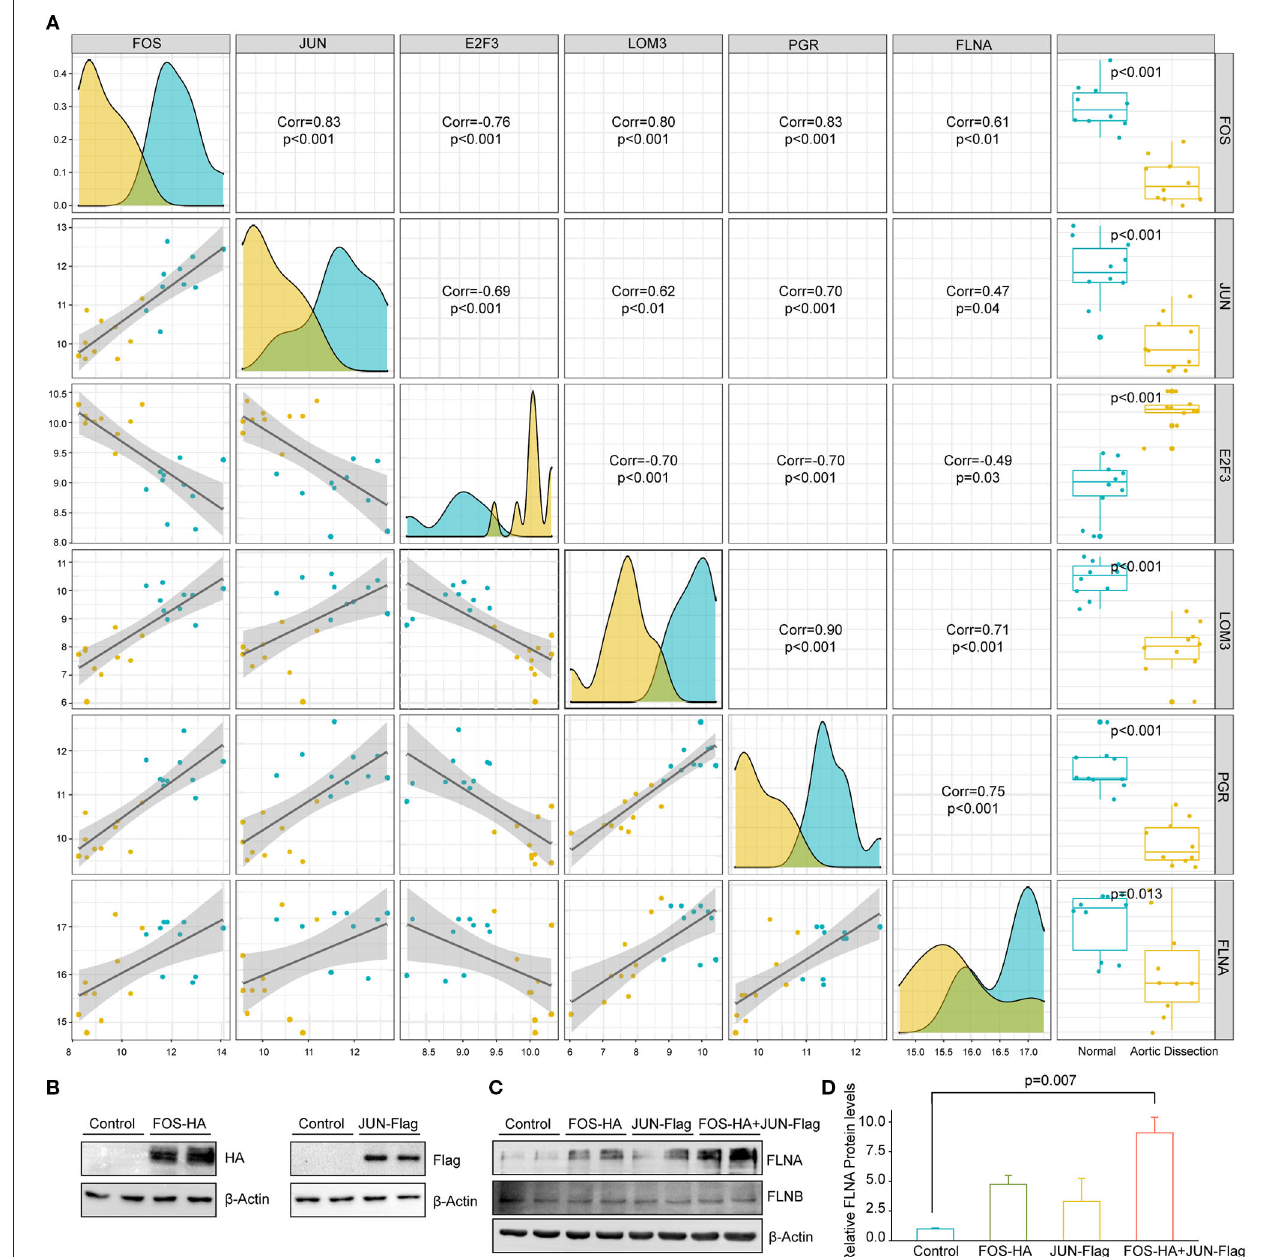
FIGURE 8 | FOS/JUN contributes to FLNA expression in HASMCs. (A) The five transcription factors mostly related to FLNA transcriptional regulation. (B) Western blotting of FOS and JUN expression in HASMCs infected with lenti-FOS-HA and lenti-JUN-Flag. (C,D) Western blot and quantitative results showing FLNA and FLNB expression in HASMCs infected with corresponding lentivirus (Control, FOS-HA, JUN-Flag, FOS-HA + JUN-Flag). β -Actin served as the loading